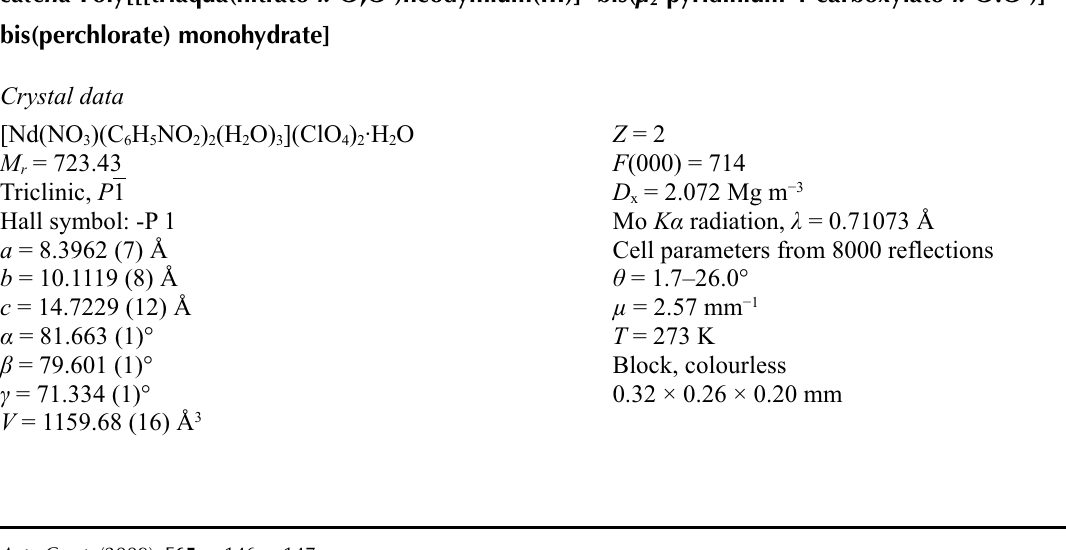
-pyridinium-4-carboxylato- κ 2 O : O ′ )] 2